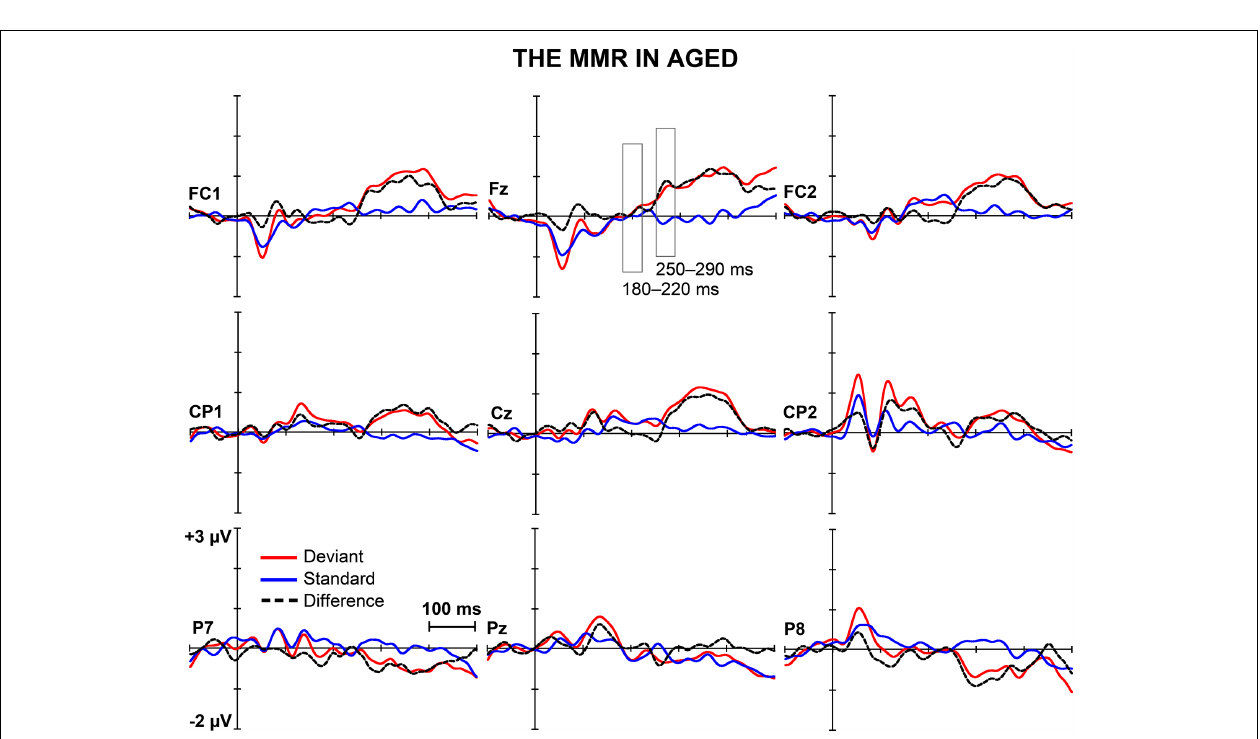
FIGURE 2 |The MMR in aged. The grand-averaged waveforms to deviant and standard stimuli and a differential waveform (deviants minus standards) within aged at electrode sites analyzed for the early and the late MMR.